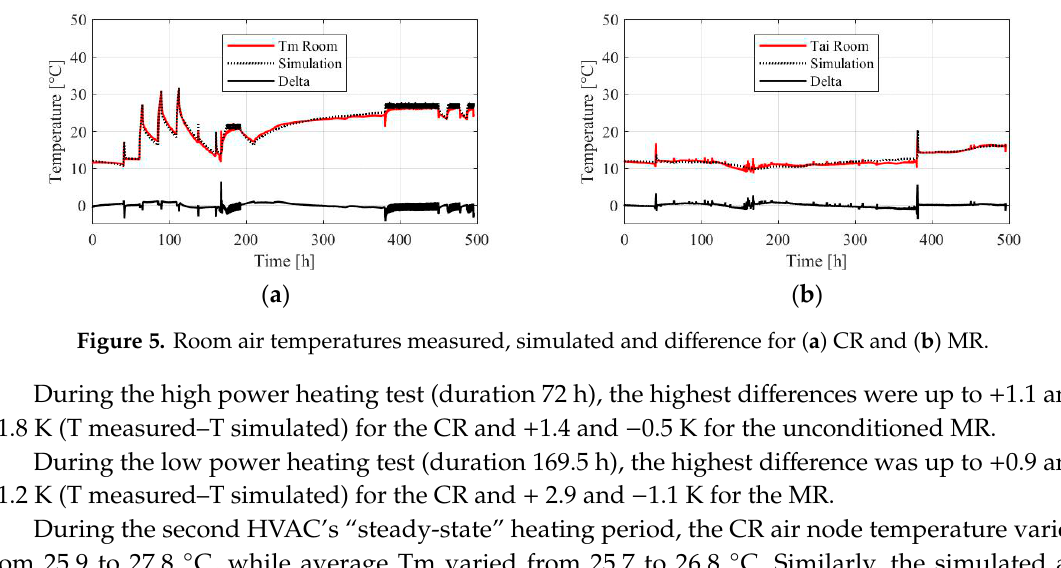
Figure 5. Room air temperatures measured, simulated and difference for ( a ) CR and ( b ) MR.